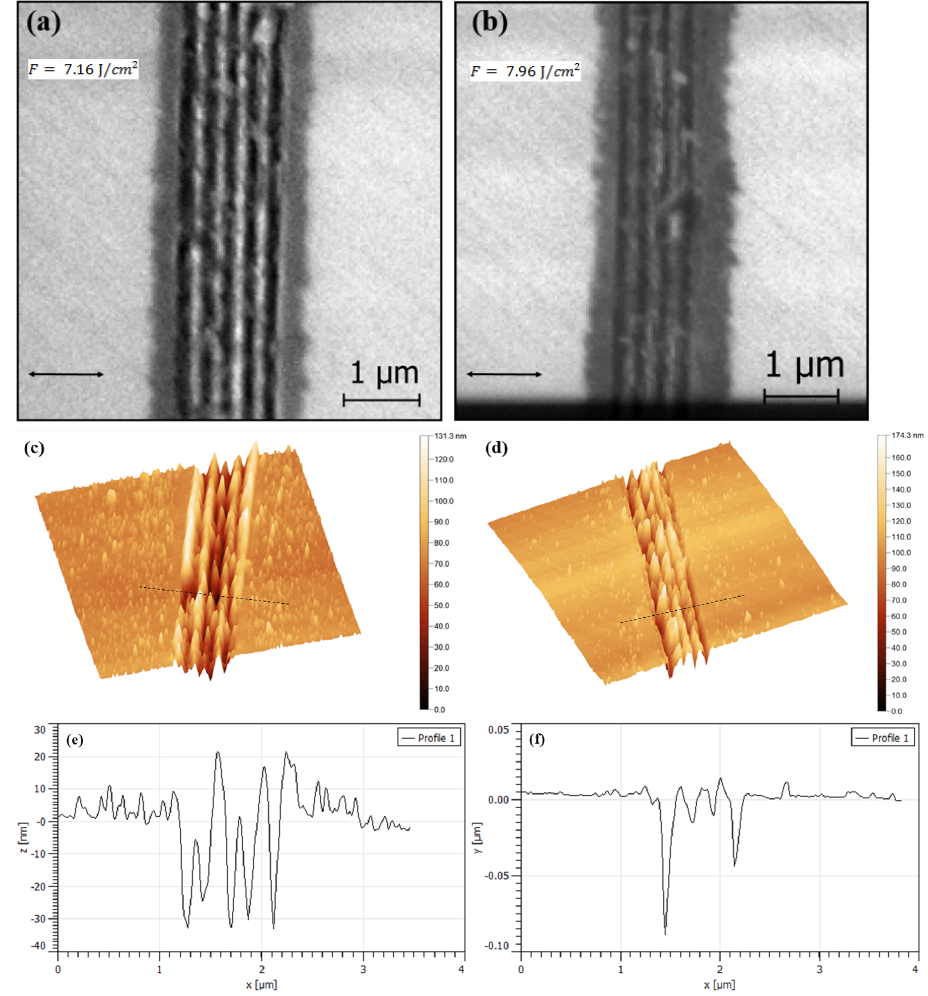
Figure 5. Representation of effect of laser fluence on the morphology of the diamond surface irradi- ated by 89 pulses (4.5 mm/s). ( a , b ) shows SEM images induced by 7.16 and F = 7.96 J/cm 2 , respec- tively. ( c , d ) AFM measurements of the ( a , b ), respectively (measured area 5 × 5 µ m 2 ). ( e , f ) represent the cross-section profile corresponding to the lines marked in ( c , d ), respectively. The double-arrow shows the polarization of the incident laser